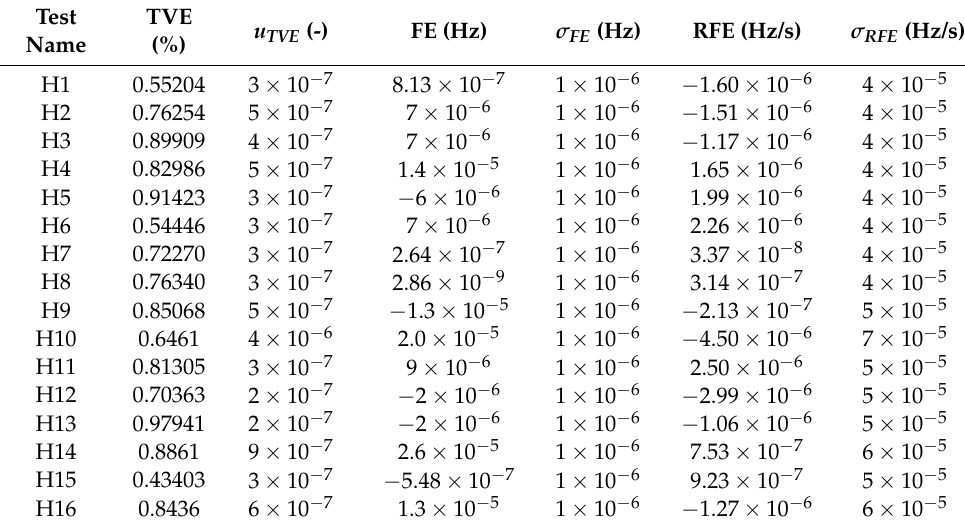
Table 21. Measurement results of the harmonic